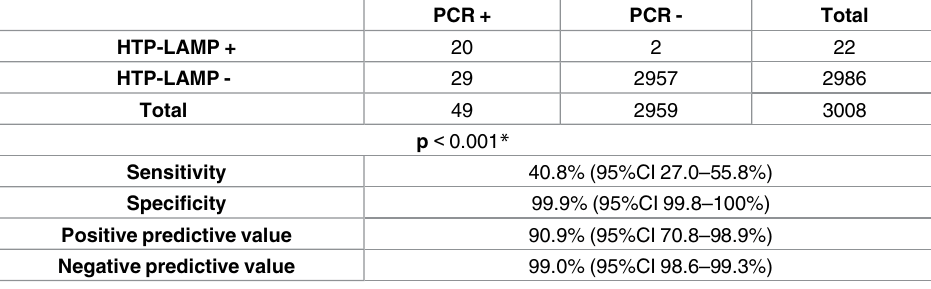
Table 3. Diagnostic accuracyof Malaria pan HTP-LAMP compared to PCR for 3008field